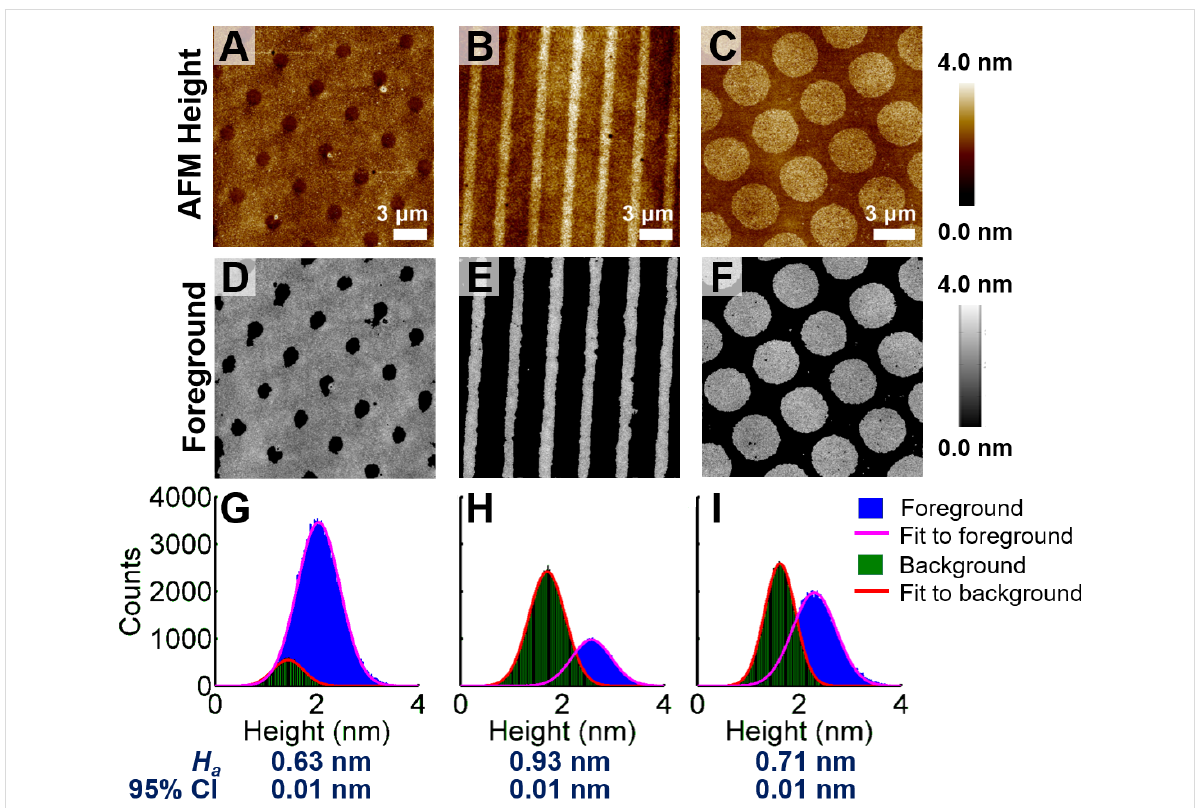
Figure 4: (A–C) Height maps of three different patterns of Au–mercaptoundecanol monolayers on poly(dimethylsiloxane) (PDMS) acquired using peak-force atomic force microscopy. (D–F) Regions classified as “foreground” are determined using the image segmentation algorithm and contain Au–mercaptoundecanol monolayers corresponding to the images shown in panels A–C. (G–I) Histograms of the heights represented by the intensi- ties of foreground and background classifications of pixels. Each histogram was fit to a Gaussian distribution and was consistent with a normal distri- bution. The calculated apparent height, H a , determined from each image was the difference in the mean of the foreground and background pixel in- tensities. The values for H a and 95% confidence intervals (95% CI) are shown below each